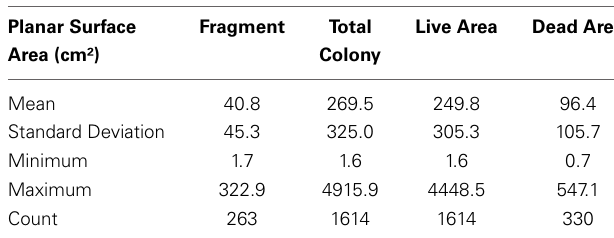
Table 3 | Pocillopora colony and fragment size